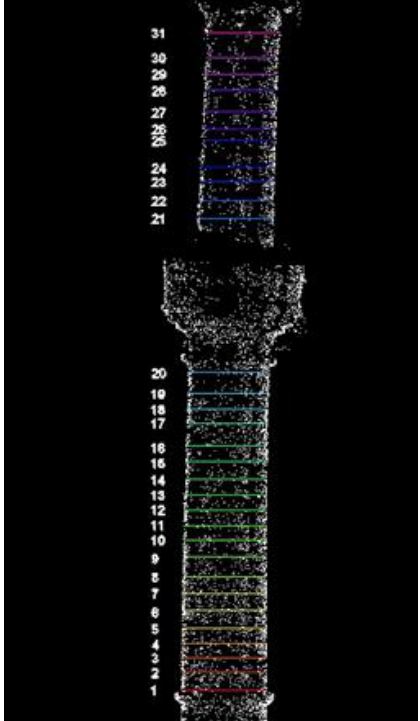
Figure 6. Sections of the minaret obtained through point